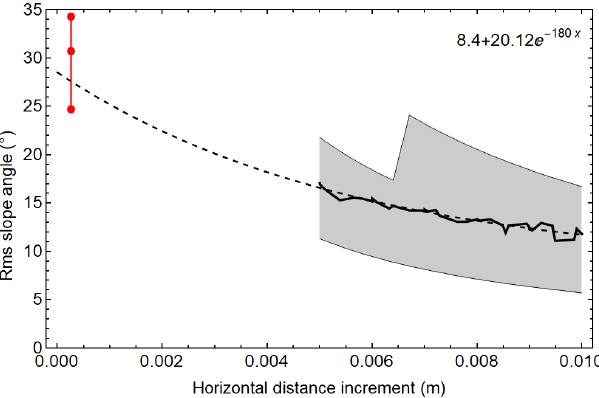
Figure 7. Relationship between rms slope angle and the horizontal distance between the points used for its determination according to the laser scanning data of 18 March 2010. For comparison the mean value and variation range of the rms slope angle values derived from the 10 plate profiles for horizontal resolution 0.25mm in the same area in the same day are shown in red. The dashed black curve is the regression to the 36 laser-scanning-based points (black polyline), and the grey shaded area covers the 80% variation range of rms slope angle at the distance in question.